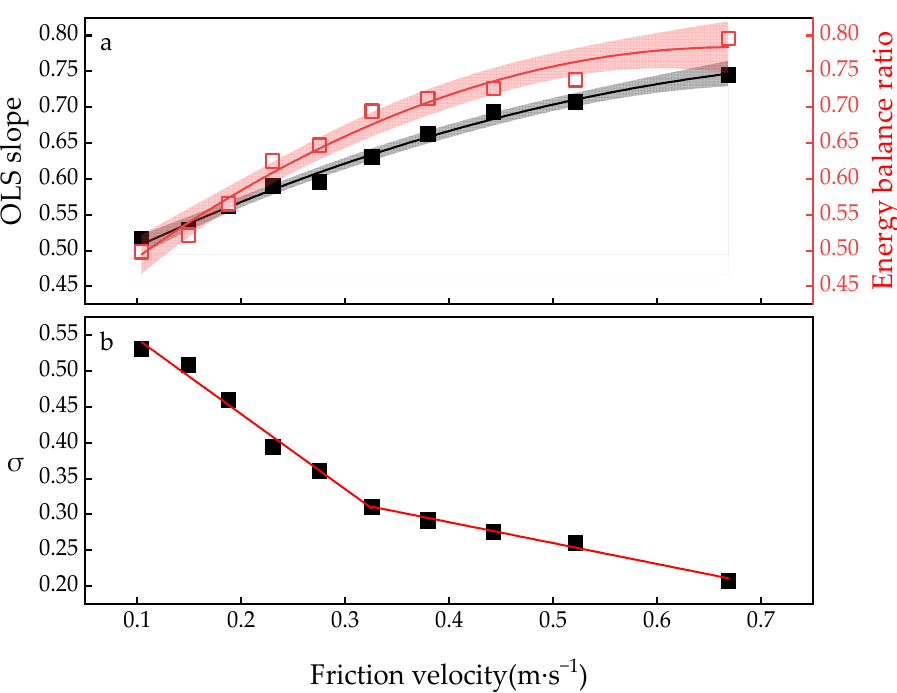
Figure 7. Effect of u* on the ( a ) EBC and ( b ) σ during daytime. The red boxes and black squares in ( a ) are the median values of EBR and OLSs per decile, and the red and black solid lines indicate their best-fit relationships with u*, which are defined as EBR = − 0.891(u*) 2 + 1.201(u*) + 0.379, R 2 = 0.98; OLSs = − 0.420 (u*) 2 + 0.747(u*) +0.435, R 2 = 0.99, respectively. In ( b ), σ is expressed as the ratio of Res